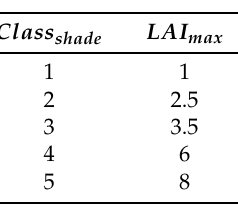
Table A9. NECN maximum LAI parameters.